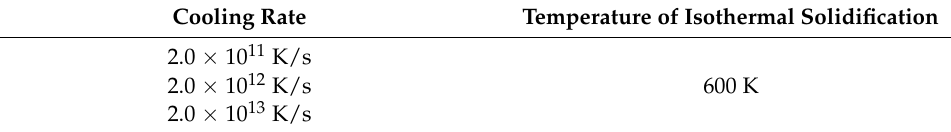
Table 2. Cooling rates and temperature of isothermal solidification used in the simulation.